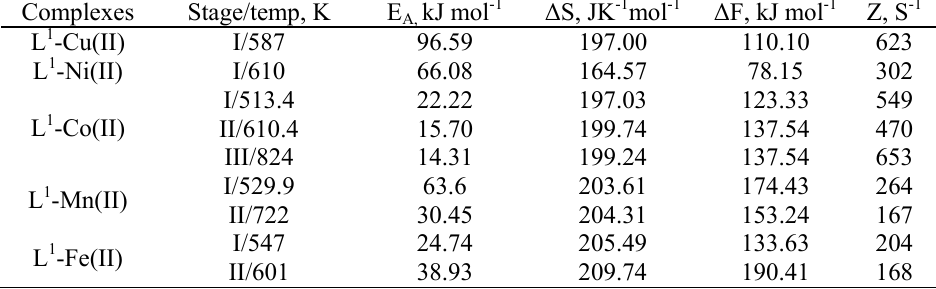
Table 5. Thermal kinetic parameters of the metal complexes calculated by Horowitz- Metzger (HM)